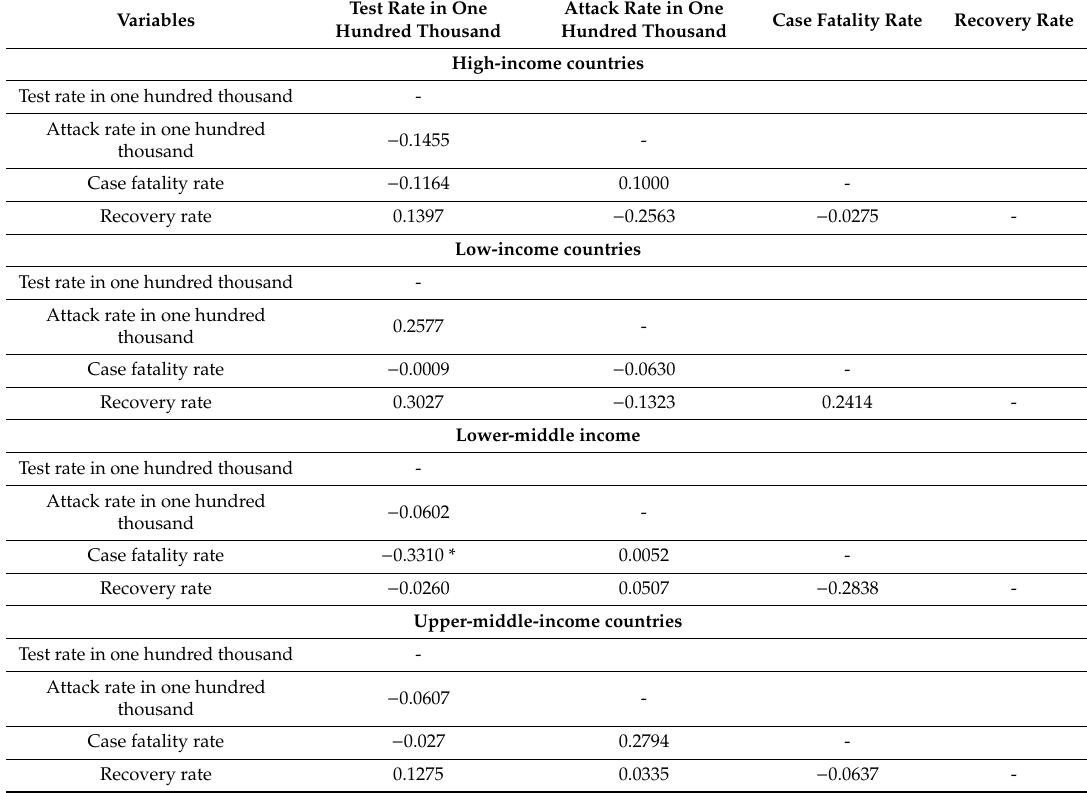
Figure 3. Correlation between urban population and recovery rate. Table 4. Correlation analysis between countries’ economic status (by group) and COVID-19 test, attack, fatality, and recovery